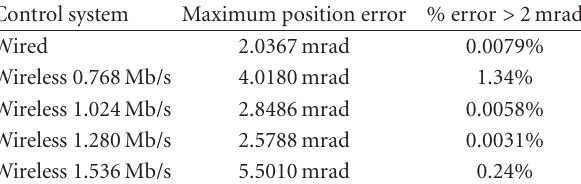
Figure 13: Position error arm. Table 3: Performance closed loop